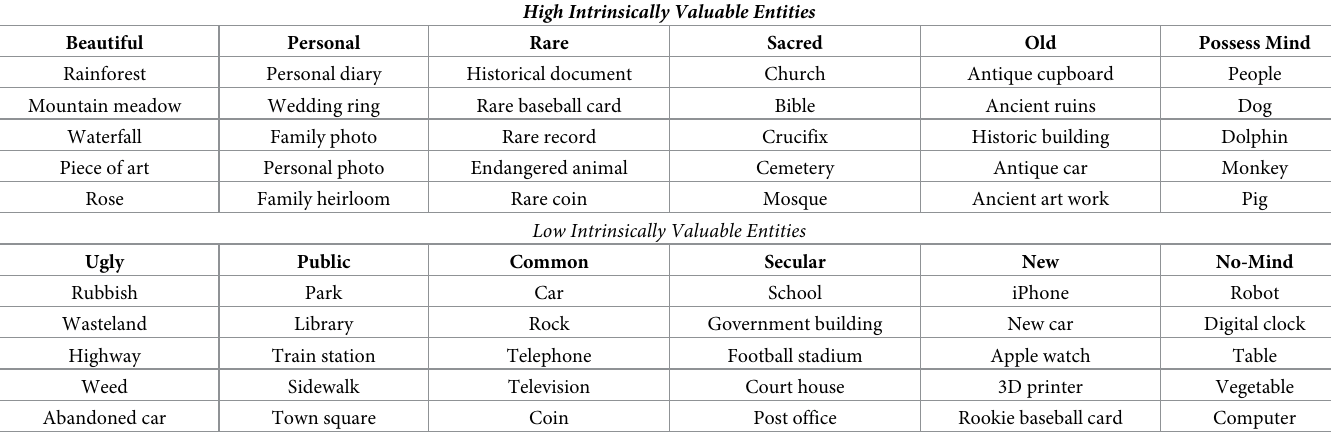
Table 2. Sixty exemplars selected to represent the twelve characteristics associated with high vs. low intrinsic value (Study